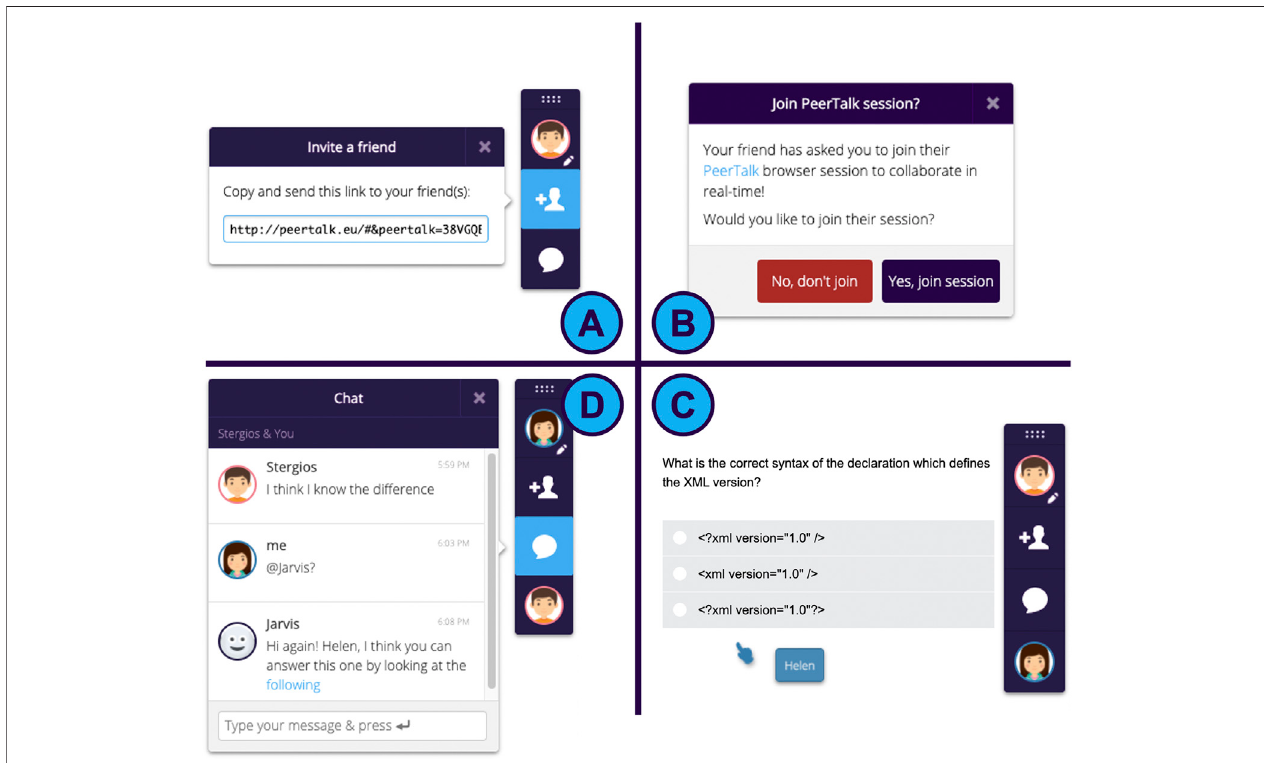
FIGURE 1 | An illustration of the steps involved in starting a PeerTalk session and forming a team.